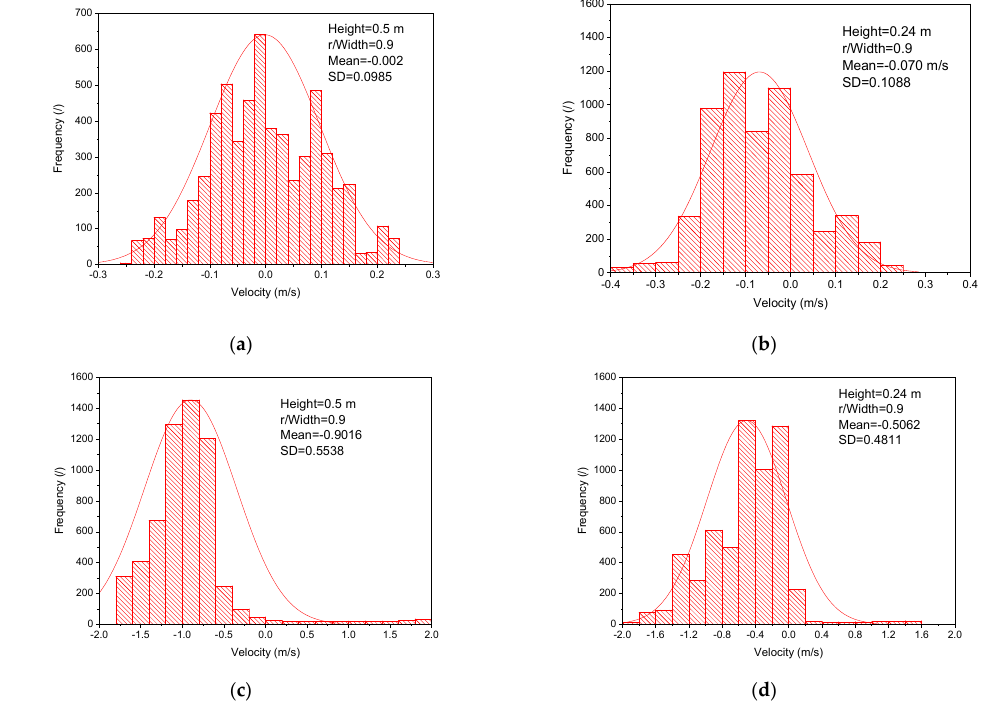
Figure 7. Histograms of wall axial and lateral velocities of EG particles at the height of 0.24 m and 0.5 m, r/Width = 0.9, ρ p = 800 kg/m 3 . ( a ) lateral velocity, 0.5 m; ( b ) lateral velocity, 0.24 m; ( c ) axial velocity, 0.5 m; ( d ) axial velocity, 0.24 m.